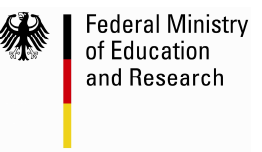
Figure S2: Geometry of the combustion chamber; Figure S3: 3D-Schematic of pellet stove type using a burner cup and fuel dropping system; Figure S4: Schematic of the test bed; Table S1: Detailed data of the experiments WP-H-L; Table S2: Detailed data of the experiments WP-L-L; Table S3: Detailed data of the experiments WP-H-S; Table S4: Detailed data of the experiments BP-H-S; Table S5: Detailed data of the experiments SP-H-S; Table S6: Detailed data of the experiments PK-H-S; Table S7: Estimated thermal efficiency for burnout phase; Table S8: Comparison of thermal efficiencies using different water temperatures as input parameters; Table S9: Comparison of thermal efficiencies using different pot parameter. References [30–34] are cited in the Supplementary